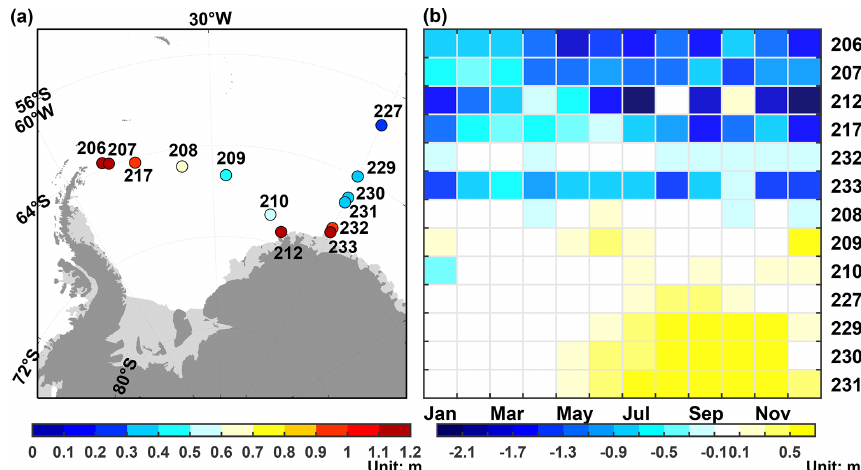
Figure 5. (a) The locations of ULSs in the Weddell Sea and corresponding standard deviation of SIT. (b) The differences in SIT climatology between GIOMAS and ULS.